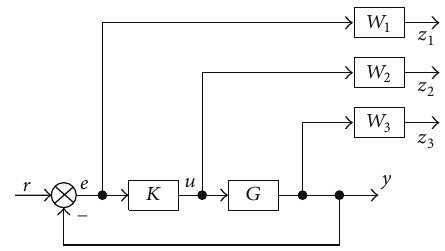
Figure 5: Structural scheme of the system augmented by means of the weighting transfer